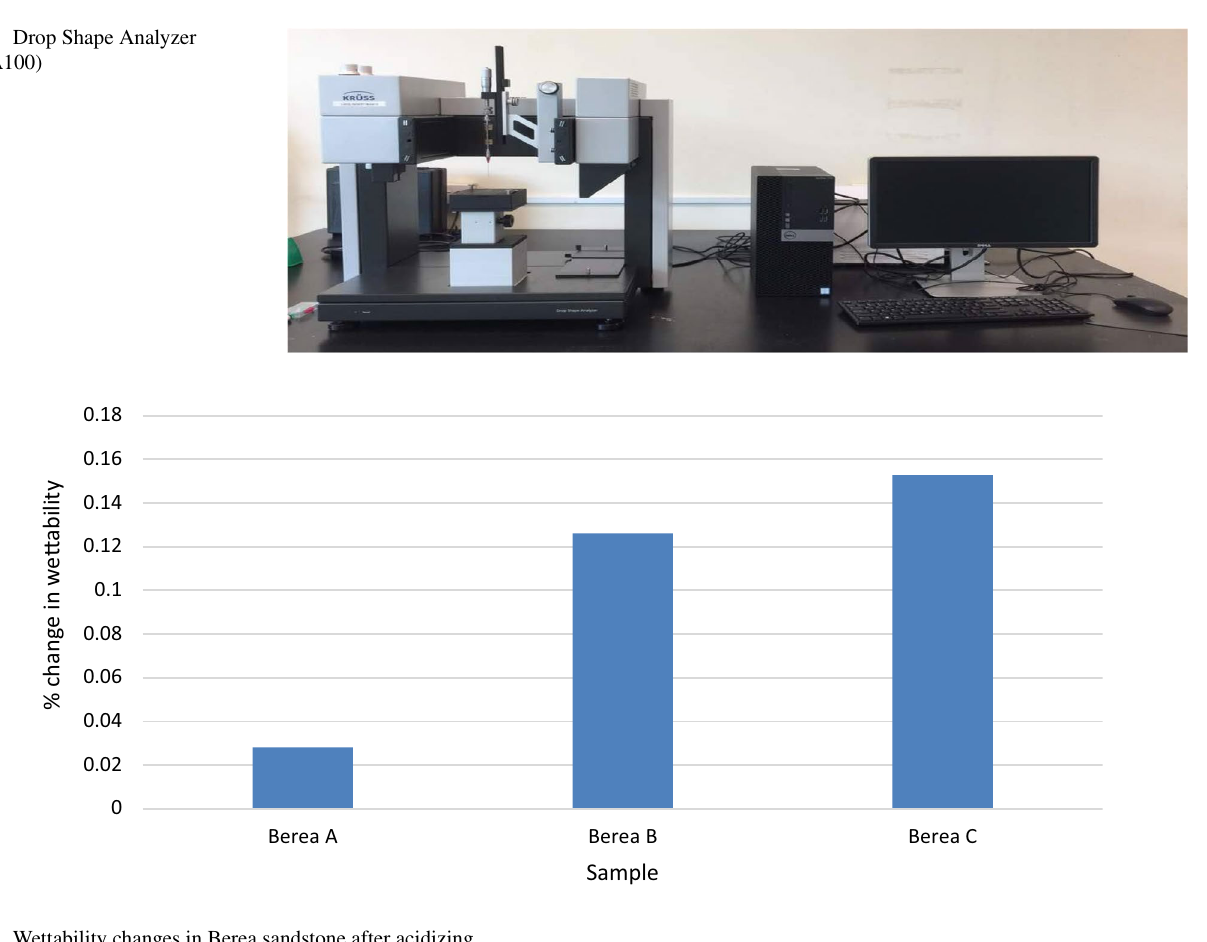
Fig. 7 Wettability changes in Berea sandstone after